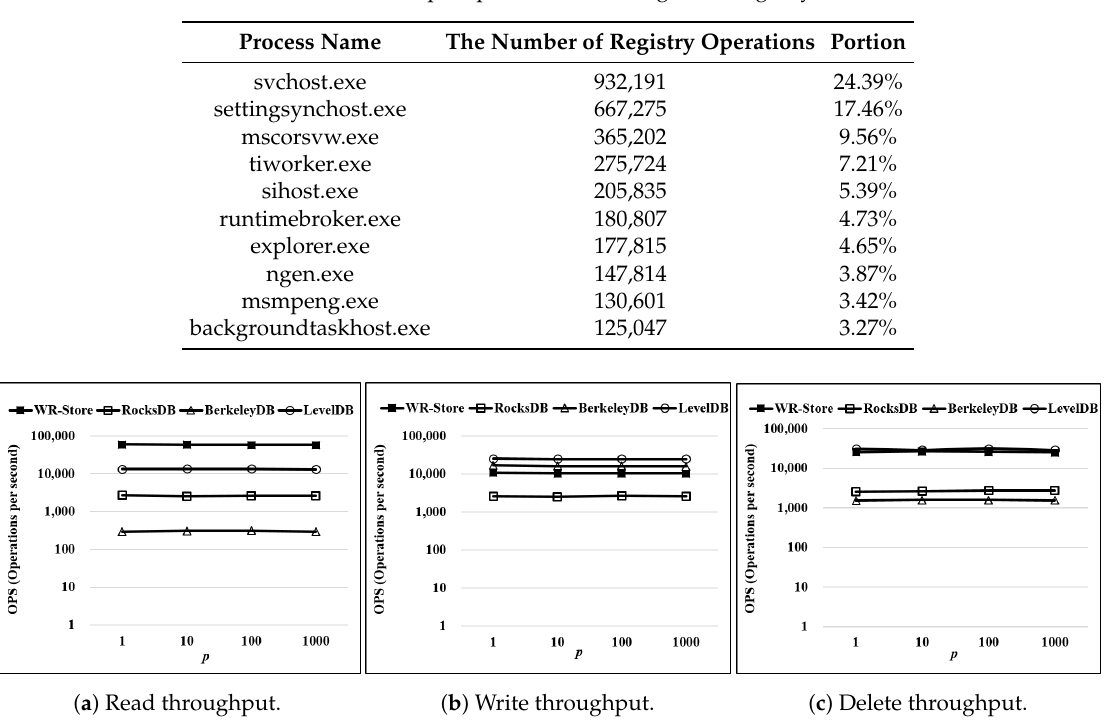
Table 9. The top-10 processes accessing to the registry.